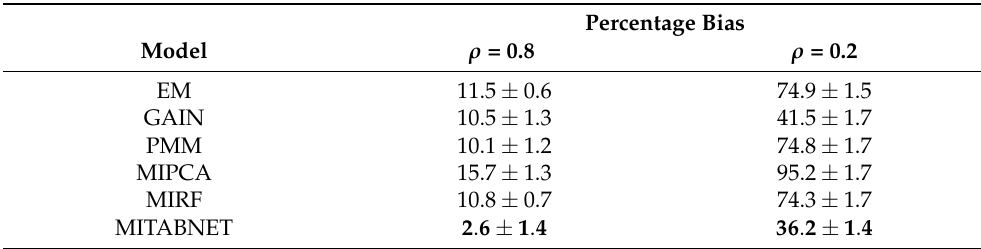
Table 3. Percentage bias in synthetic data: high and low correlation scenario for a sample size of 10,000.